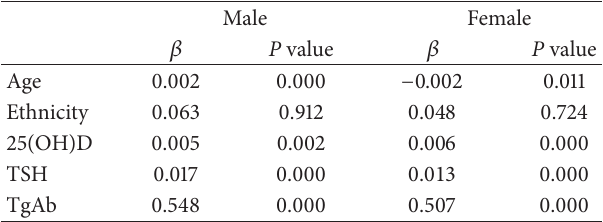
Table 4: Linear regression analysis with serum TPOAb as a dependent variable.